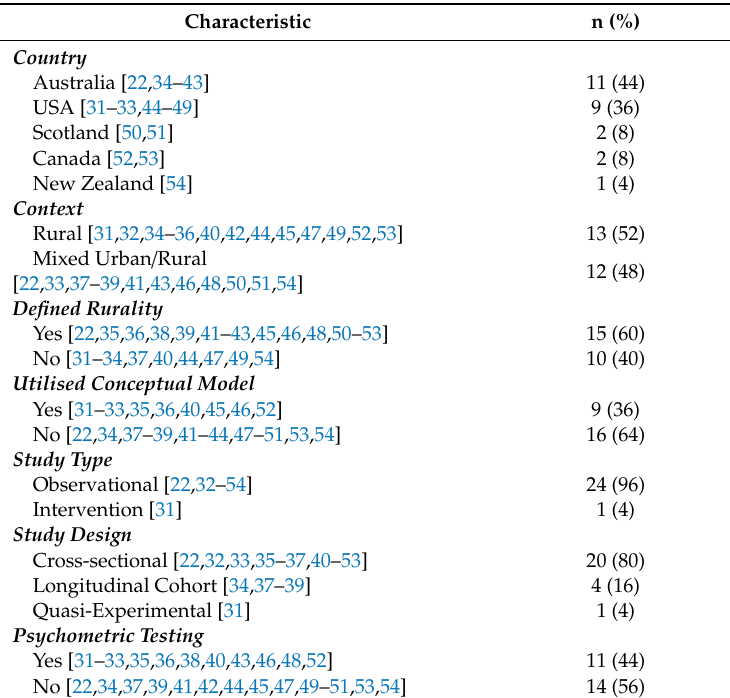
Table 1. Overview of studies (n =